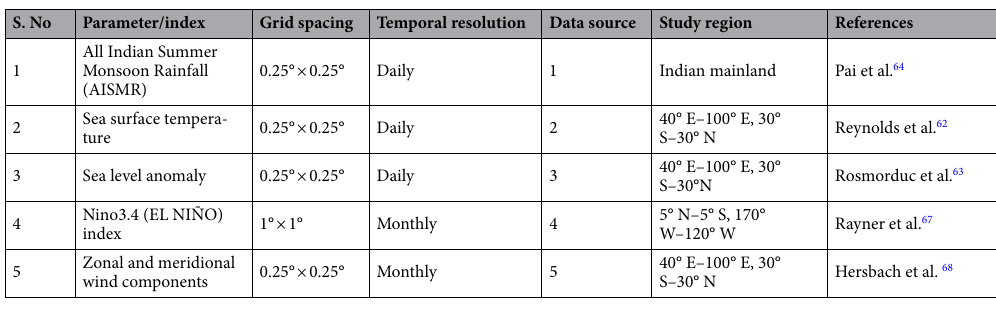
Table 2. Details of data used in the